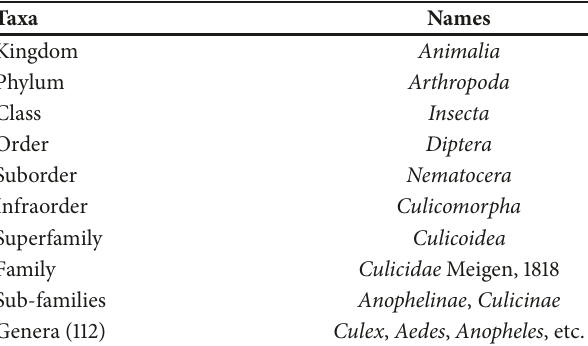
Table 2: Taxonomic classification of mosquitoes (Diptera: Culici-